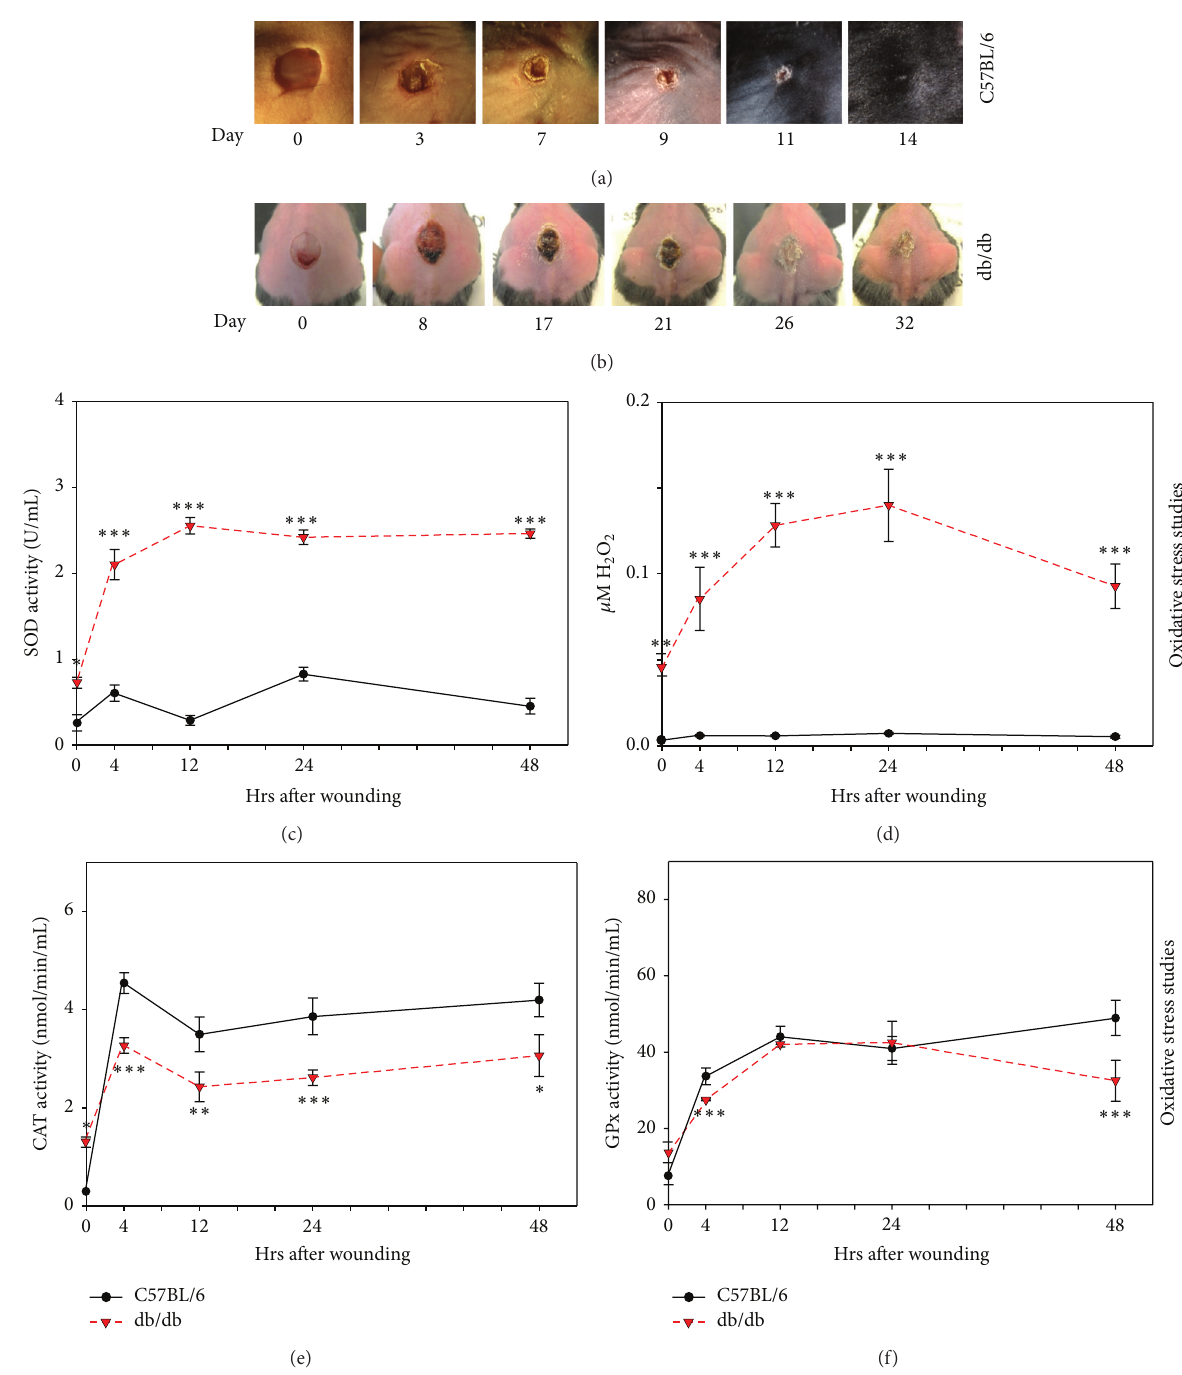
Figure 1: db/db mouse wounds have increased oxidative stress and delayed healing: time course of wound closure in C57BL/6 mice (a) and in db/db mice (b). Wound areas were traced and analyzed using Image J and show delayed closure as compared to C57BL/6. (c) SOD activity was measured using tetrazolium salt that converts into a formazan dye detectable at 450 nm. SOD activity was significantly elevated in the db/db wounds. (d) H 2 O 2 measurements were based on the peroxidase-catalyzed oxidation by H 2 O 2 and fluorescent product resorufin read fluorometrically at 530 nm/605 nm. H 2 O 2 levels were significantly higher in the db/db wounds, confirming the elevated SOD activity in the early hours after wounding. (e) Catalase activity was measured by an enzymatic reaction spectrophotometrically detected with the chromogen purpald at 540 nm and showed reduced activity in the db/db wounds, suggesting a buildup in H 2 O 2 . (f) GPx activity was measured by a coupled reaction with glutathione reductase where GPx activity was rate limiting and absorbance was read at 340 nm per 1min intervals. GPx activity showed significantly lower levels at 4 hrs and 48hrs after wounding. These levels confirm improper detoxification of H 2 O 2 leading to redox stress. Time zero represents unwounded skin. 𝑛 = 6 . All data are mean ± SD. ∗ 𝑃 < 0.05 , ∗∗ 𝑃 < 0.01 , ∗∗∗ 𝑃 < 0.001 . 𝑛 = 6 for each of the studies unless indicated